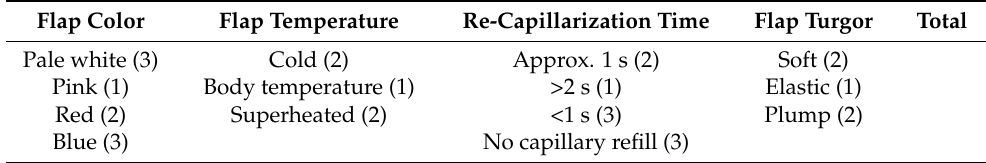
Table 1. Clinical flap evaluation system with point